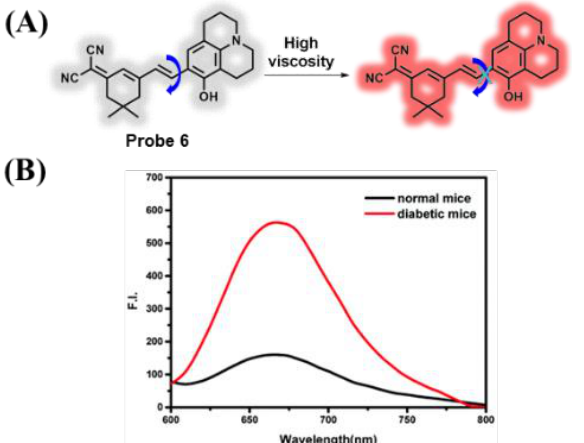
Figure 4. ( A ) Imaging mechanism of probe 6 ; ( B ) the fluorescence spectra of probe 6 in the fresh blood of normal and diabetic mice, respectively, λ ex = 510 nm. Adapted from Reference [60]. Copyright 2020, the Royal Society of Chemistry.